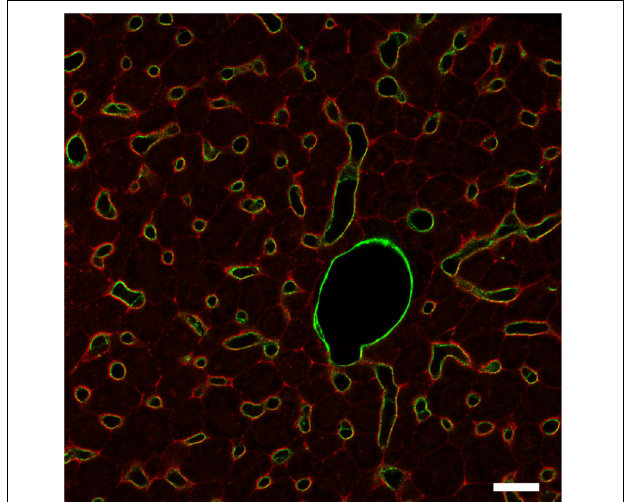
FIGURE 5 | BGT1 localization in the liver. The section was double labeled with anti-CD31 antibodies (green; 0.5 μ g/ml; endothelial marker) and anti-BGT1 antibodies (red; Ab#594; 1 μ g/ml). Scale bars = 20 μ m. Immunochemistry was performed using the same materials and procedures described in detail by Zhou et al.